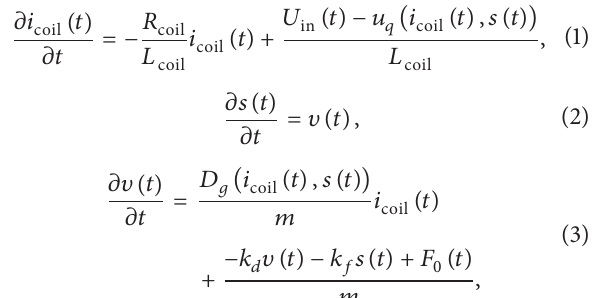
are possible in spite of relatively low switching